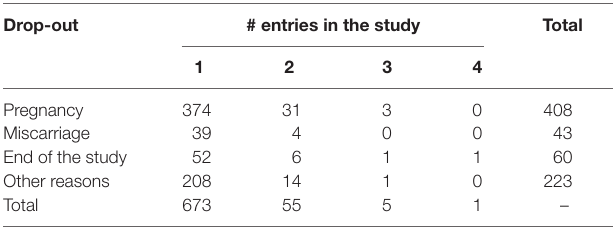
# women % Table 4 | Number of women according to drop-out reasons and number of entries in the study.